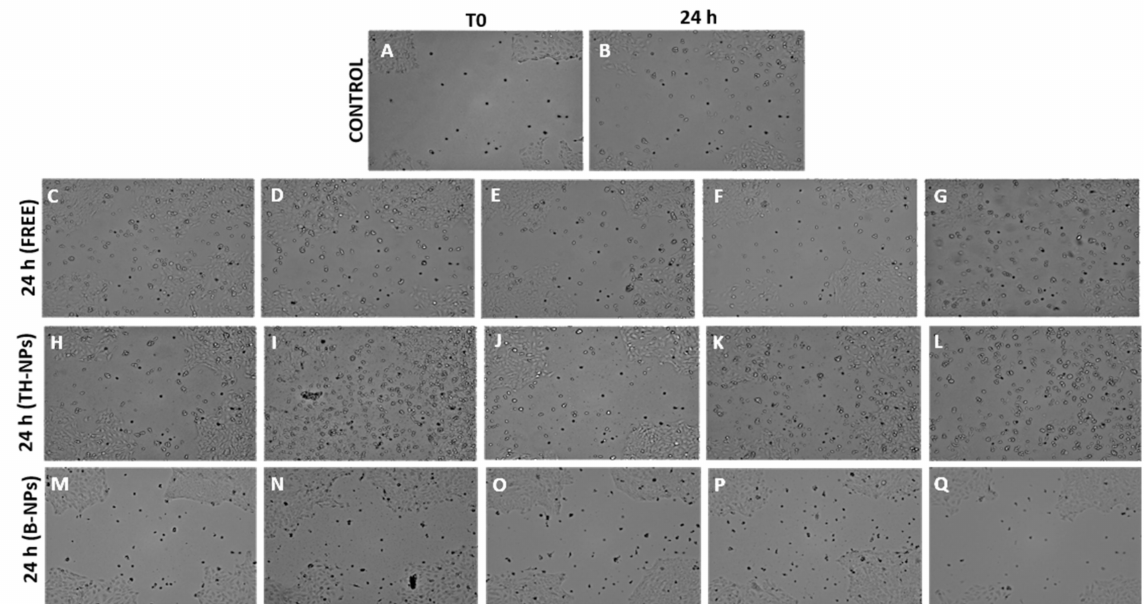
Figure 12. Recorded images of wound healing activity in HaCaT cells under post-scratch treatment (wound healing treatment). ( A ) Control T0, ( B ) Control after 24 h incubation, ( C ) Free TH, ( D ) Poloxamer 188, ( E ) poloxamer 407, ( F ) chitosan, ( G ) phosphatidylcholine, ( H ) TH-NP-P-, ( I ) TH-NP-P-C+, ( J ) TH-NP-PP-, ( K ) TH-NP-PP-C+, ( L ) TH-NP-L-, ( M ) B-TH-NP-P-, ( N ) B-NP-P-C+, ( O ) B-NP-PP-, ( P ) B-NP-PP-C+, ( Q )